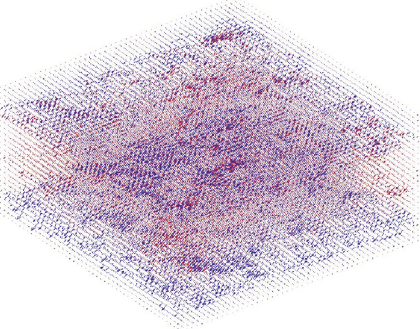
Figure 8: MWX crustal section fluid flow velocity vector distribu- tion from Figure 1 poroperm structure. Blue arrows denote fluid flow in the major fault horizons of Figure 1. Red arrows denote fluid flow in the remaining crustal volume. It can be noted that Figure 1 spatial poroperm heterogeneity leads to azimuthally erratic flow paths within the faults and within the embedding ambient crustal volume. In the present horizontally stratified flow structure, heat transport modelled by spatially averaged flow will probably provide a reasonable wellbore temperature distribution. In the presence of more complex faulting, however, a spatially averaged poroperm mediumwouldprovideapoorapproximationtotheresultanterratic wellbore temperature